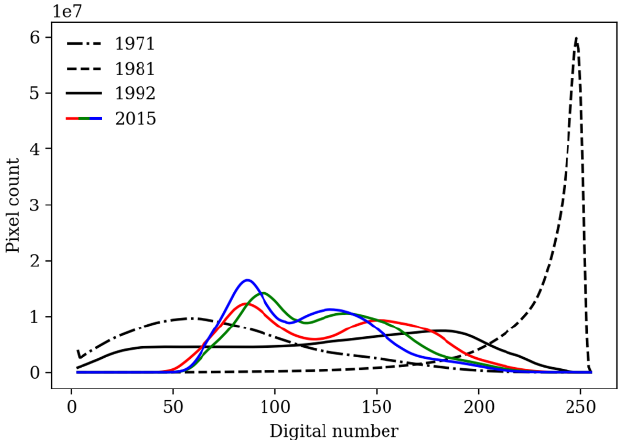
Figure 2. Digital number distribution of the four orthophotos (after upsampling to the resolution of the 2015